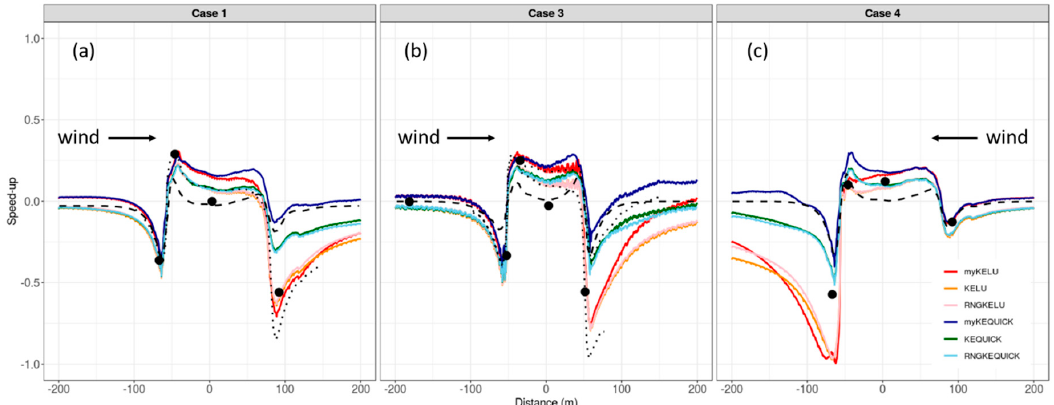
Figure 12. Model comparisons to observed data at Bolund Hill for ( a ) Case 1; ( b ) Case 3 and; ( c ) Case 4. Black circles are observed data. The x-axis is distance along the transect. The y-axis is fractional speed-up relative to the observed speed at a reference station upwind. Black dashed lines are the COM solver results. Dotted black lines are LES results redrawn from Bechmann et al. [21] and Vuorinen et al. [37].